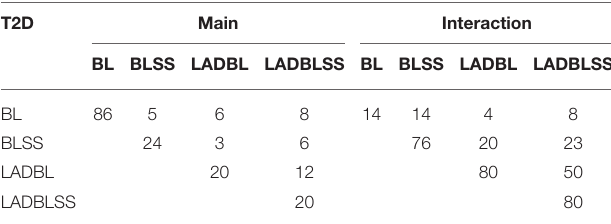
TABLE 3 | The numbers of main G effects and interactions identified by different approaches and their overlaps for BL (Bayesian LASSO), BLSS (Bayesian LASSO with spike-and-slab priors), LADBL (LAD Bayesian LASSO), and LADBLSS (LAD Bayesian LASSO with spike-and-slab